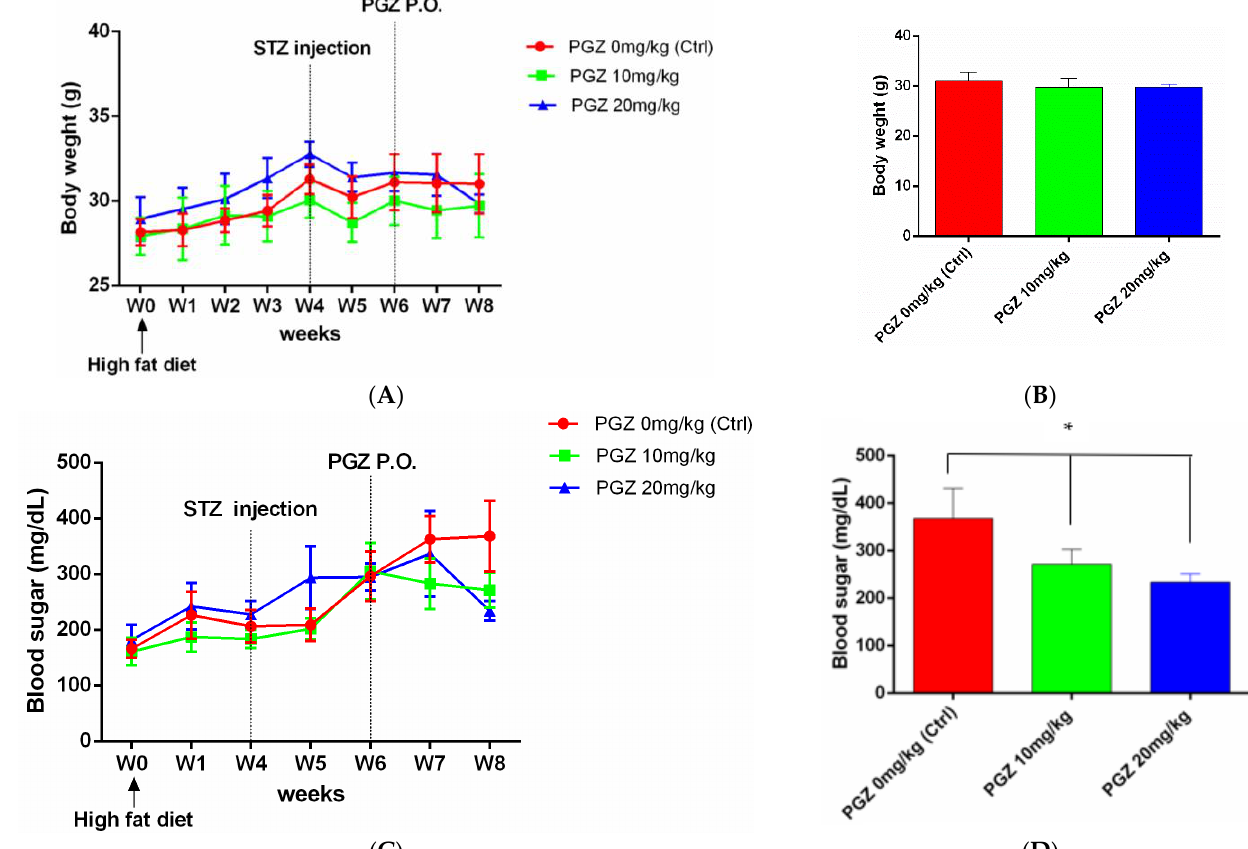
Figure 1. Blood glucose levels and body weights of mice. ( A ) Increase in body weight after high fat diet (HFD) rearing. ( B ) No significant difference in body weight between diabetic mice treated with 20, 10, and 0 mg/kg pioglitazone (PGZ). ( C ) Increase in blood glucose levels after streptozotocin (STZ) injection. ( D ) Diabetic mice treated with 20 mg/kg PGZ for 2 weeks had a lower level of blood sugar than those treated with 10 and 0 mg/kg PGZ (* p <